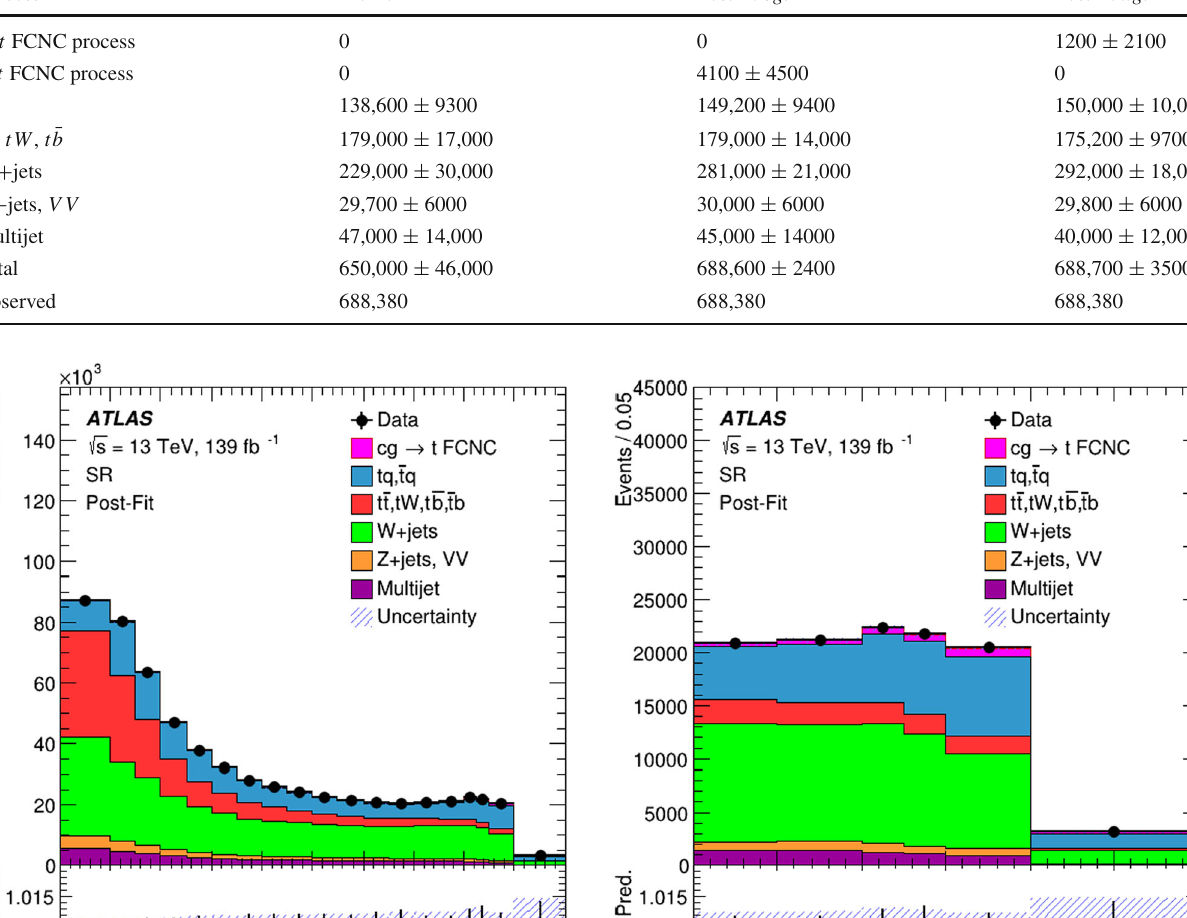
discriminant region between 0 . 7 and 1 . 0. The hatched bands represent the post-fit uncertainty of the total event yield in each bin. Correlations among uncertainties were taken into account as determined in the